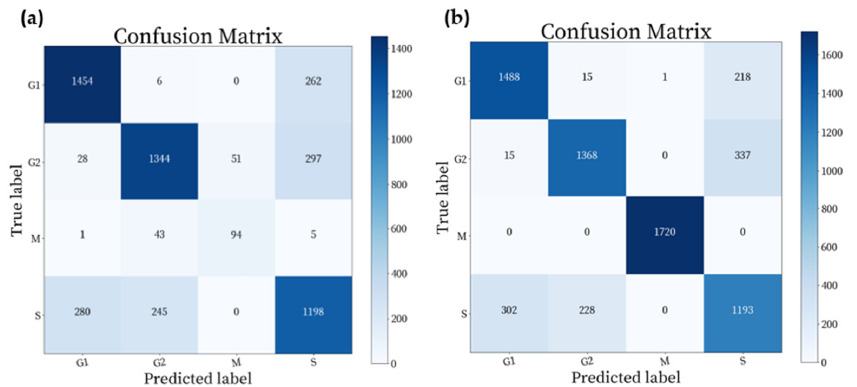
Figure 7. The confusion matrix of classification. ( a ) Four-stage classification of original images; ( b ) four-stages classification of generated images.